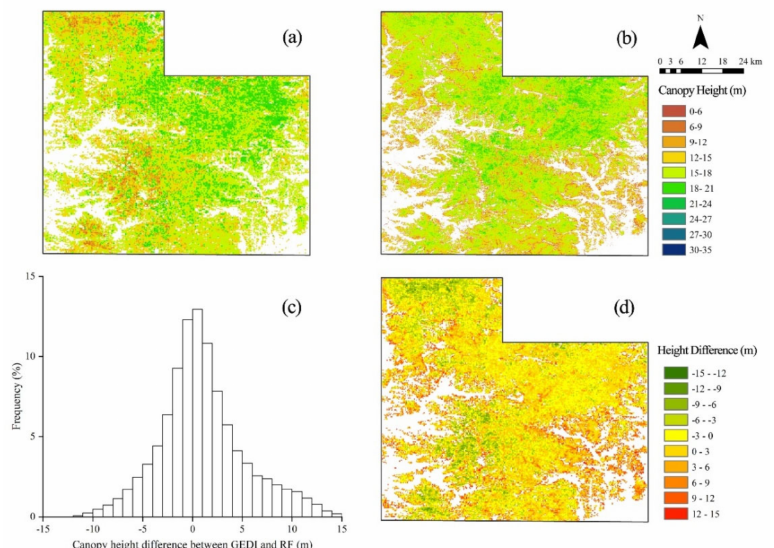
Figure 9. Spatial analysis for predicted forest canopy height map and GEDI-derived forest canopy height map in Area 1. ( a – d ) represent predicted forest canopy height map, GEDI-derived forest canopy map, frequency histogram for canopy height difference, and distributions for canopy height difference with 250 m